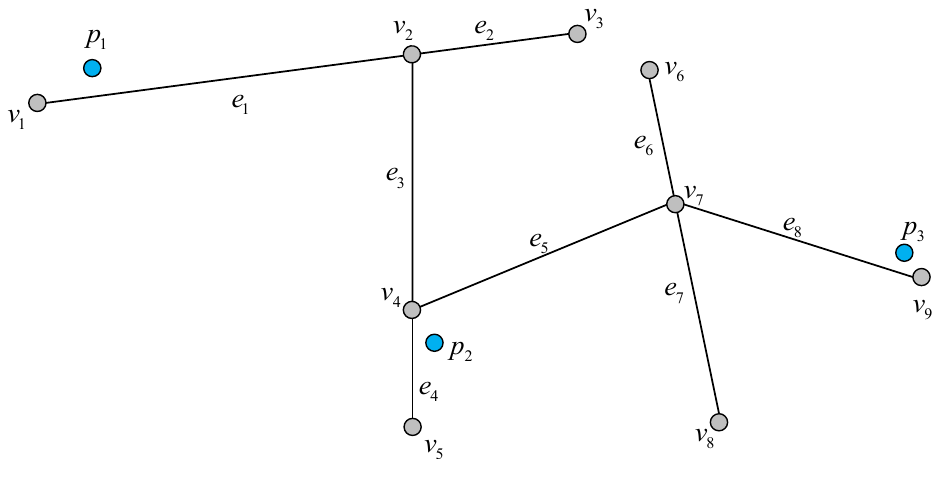
Figure 8. Problems in the search for matching paths. Table 1. k cases of candidate